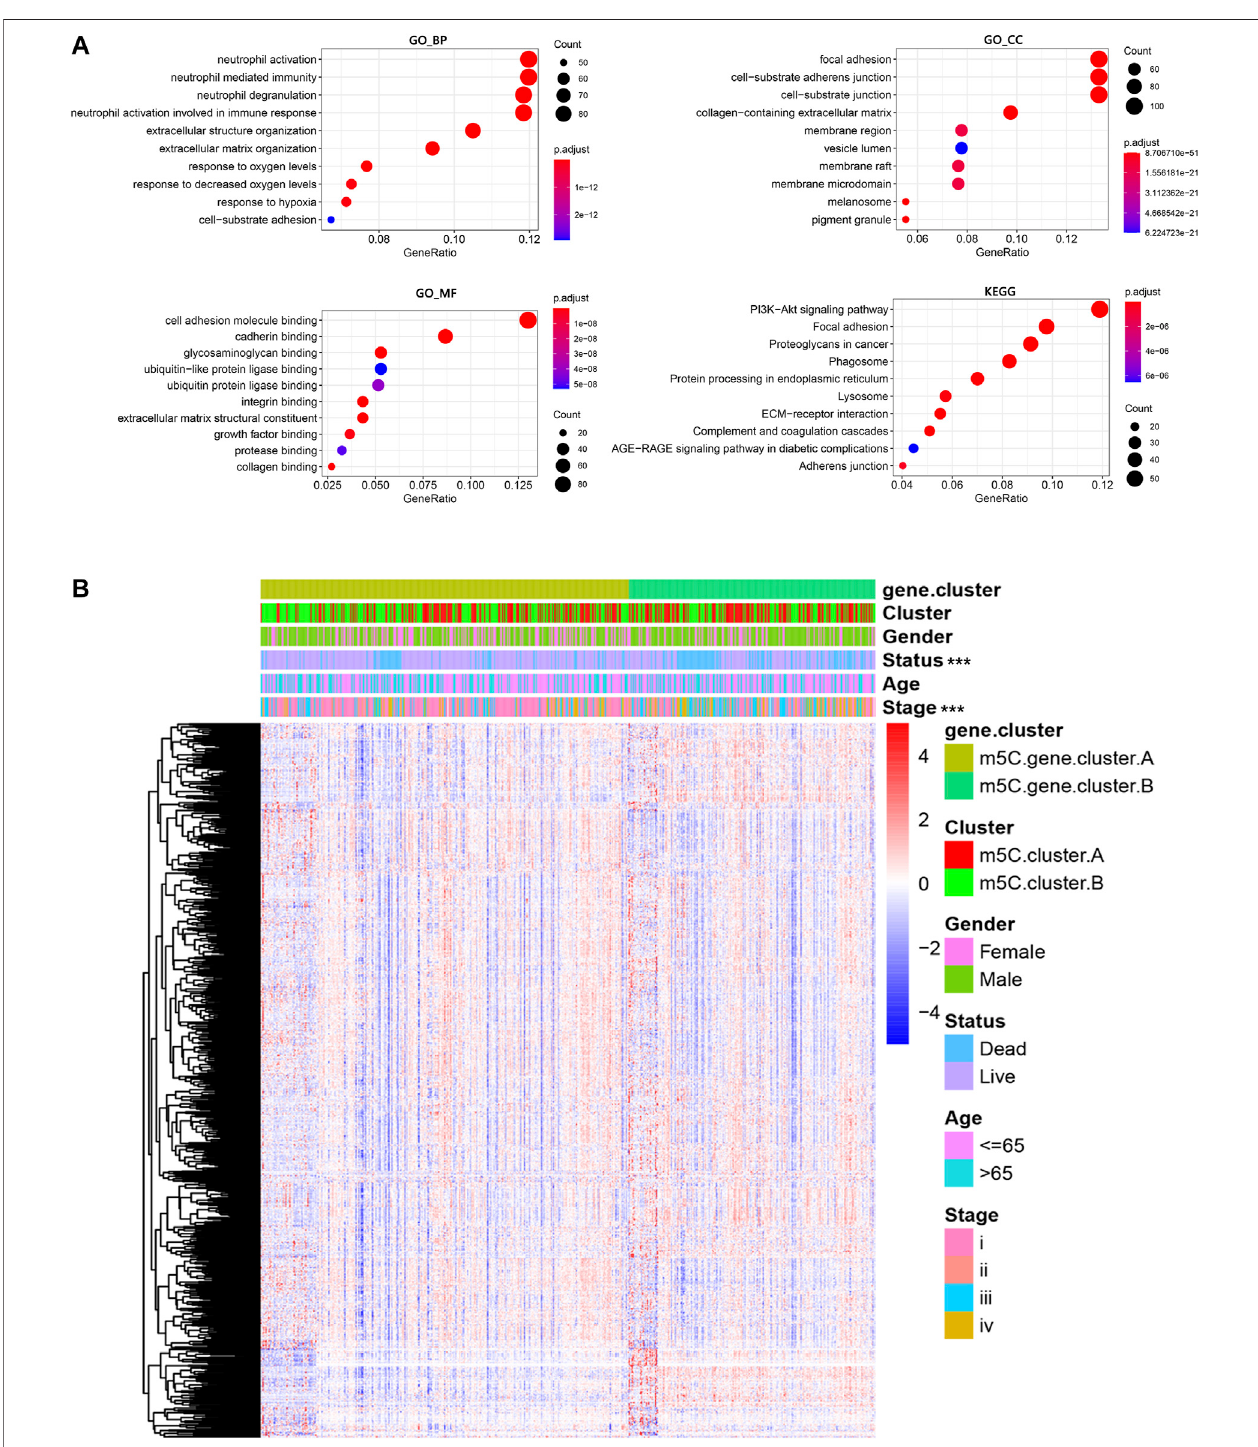
FIGURE5| Functionalannotationsofm 5 Cgenotypesignatures. (A) FunctionalenrichmentresultsoftheDEGs. (B) IntegrativeheatmapincludingDEGexpression, gender, age, clinical stage, and survival status in the two m 5 C modi fi cation pattern groups.